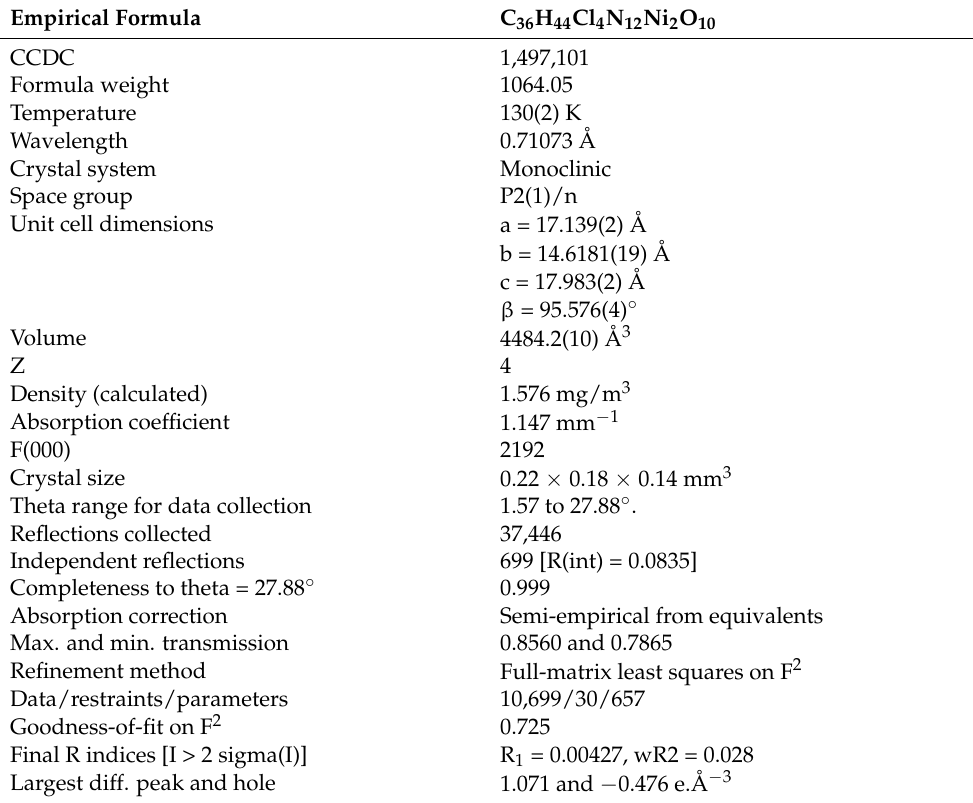
Table 1. Exp. XRD data of {[Ni(tptz)Cl(H 2 O) 2 ][Ni(tptz)(H 2 O) 3 ]}3Cl.5H 2